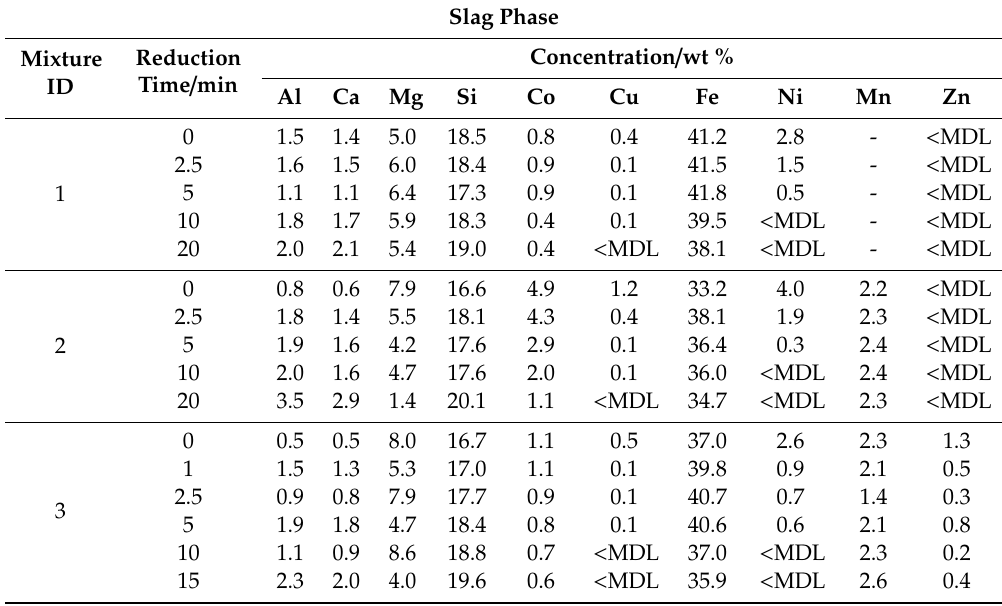
Table A1. Average elemental concentrations (wt %) in slag as a function of time in di ff erent series, presented with a one decimal accuracy. < MDL = below the minimum detection limit of EDS.